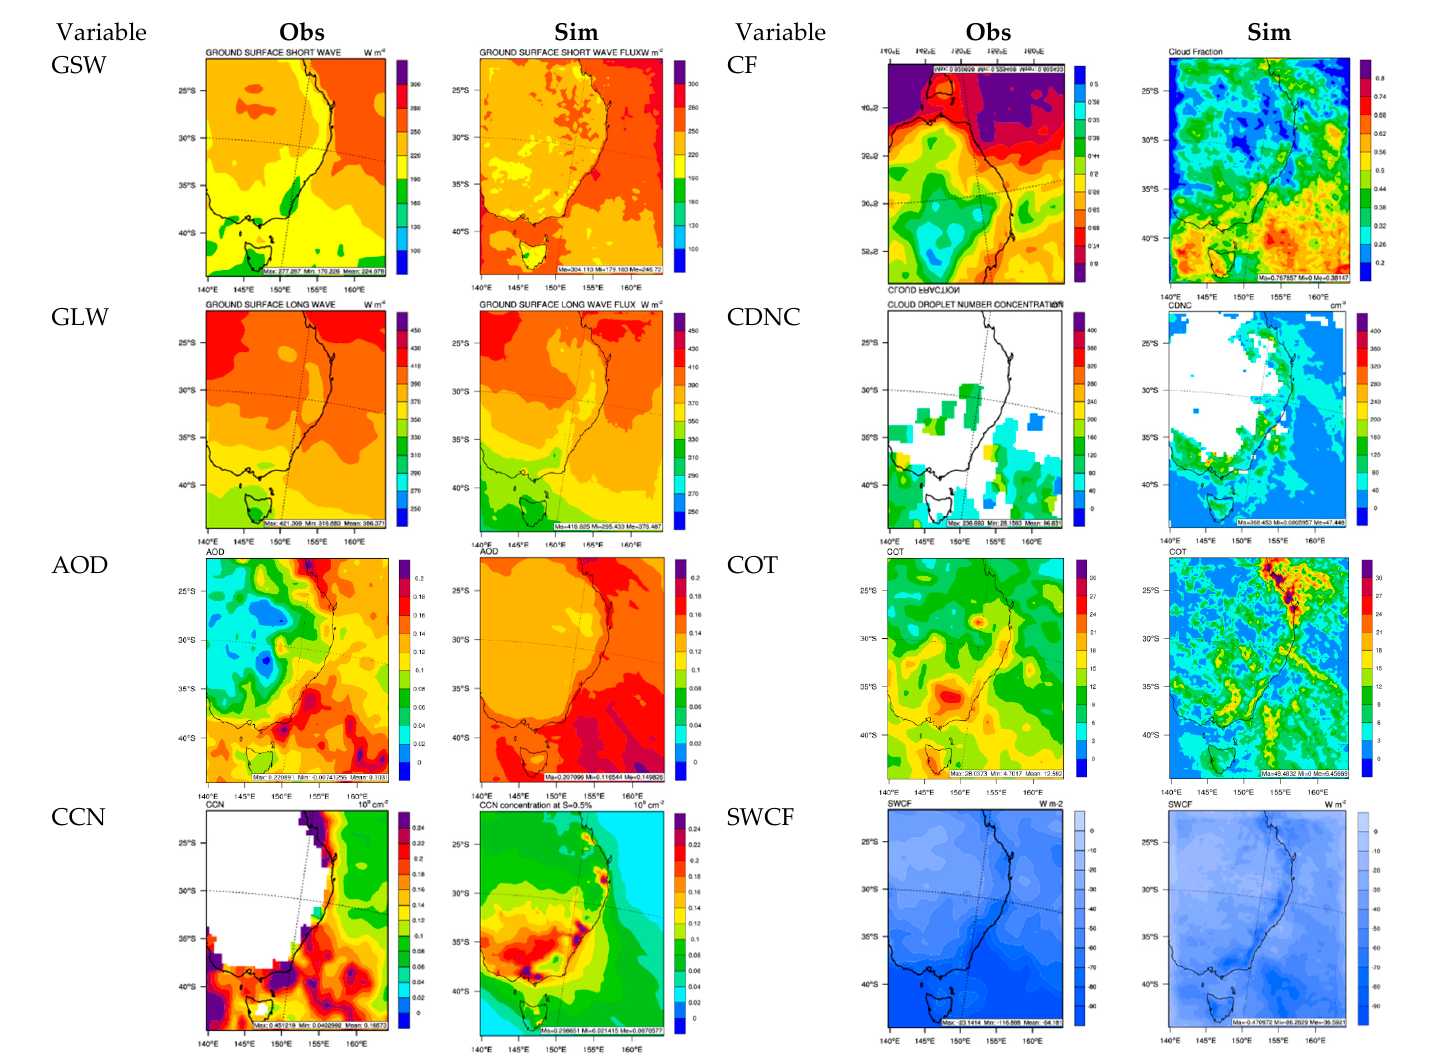
Figure 10. Observed and simulated radiation and optical variables and CCN over southeastern Australia (d02) during SPS1. The simulation results are from WRF/Chem-ROMS.